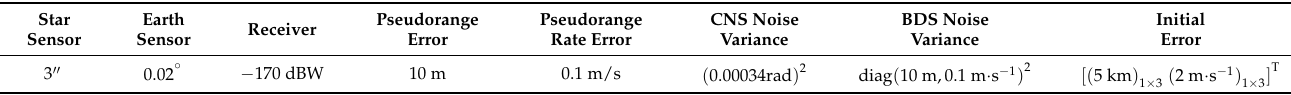
Table 11. Sensors and filter parameter